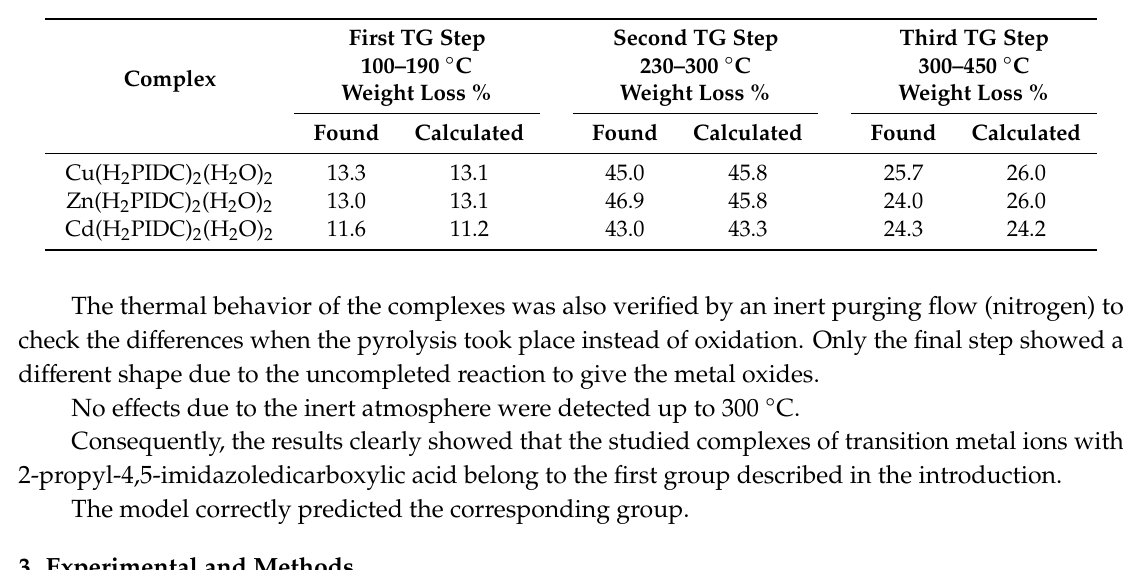
Table 2. Temperature range of the main thermal steps and the corresponding percent weight